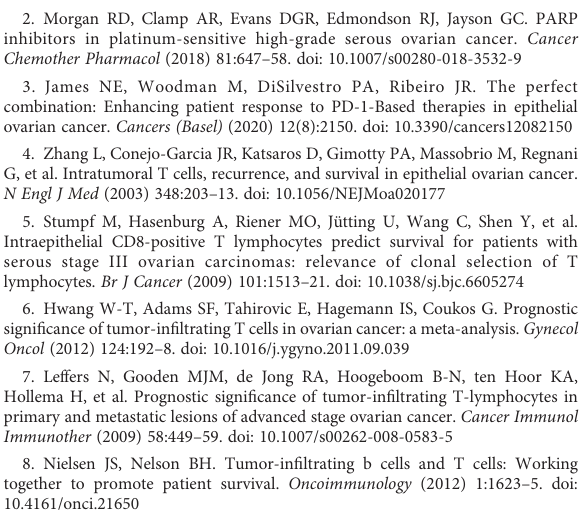
SUPPLEMENTARY TABLE 1 All differentially expressed genes post-NACT vs. pre-NACT.